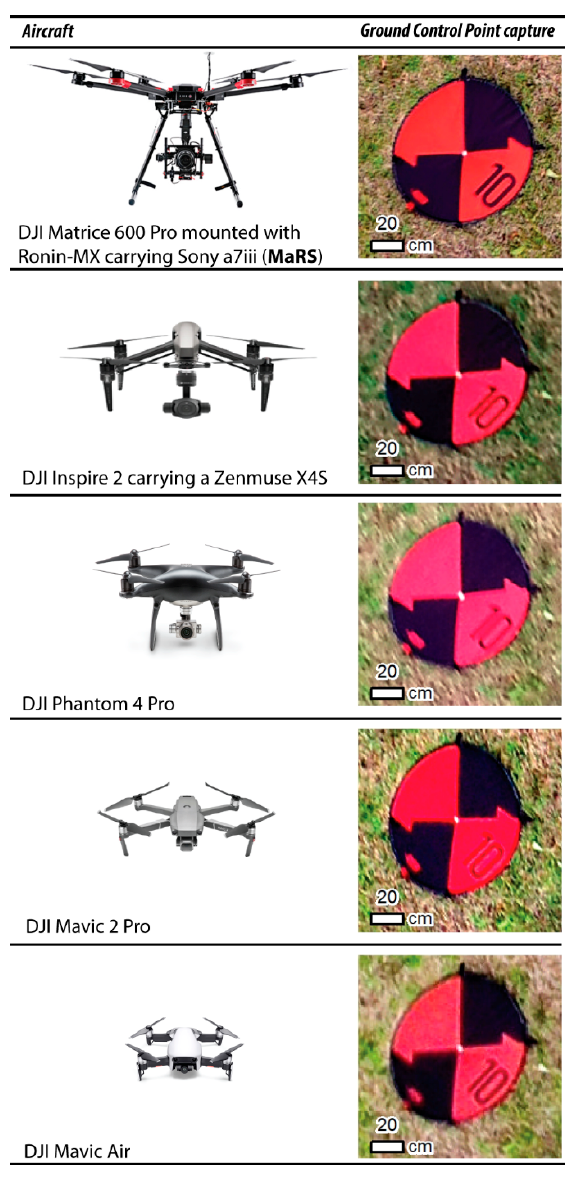
Figure 2. The five aircraft used in this study along with an example of each camera’s ability to capture a Ground Control Point (GCP). Aircraft image source: https://www.dji.com/ (accessed on Table 2. Specifications of the five small unmanned aerial systems (sUAS) and their respective sensor used in this study. Aircraft